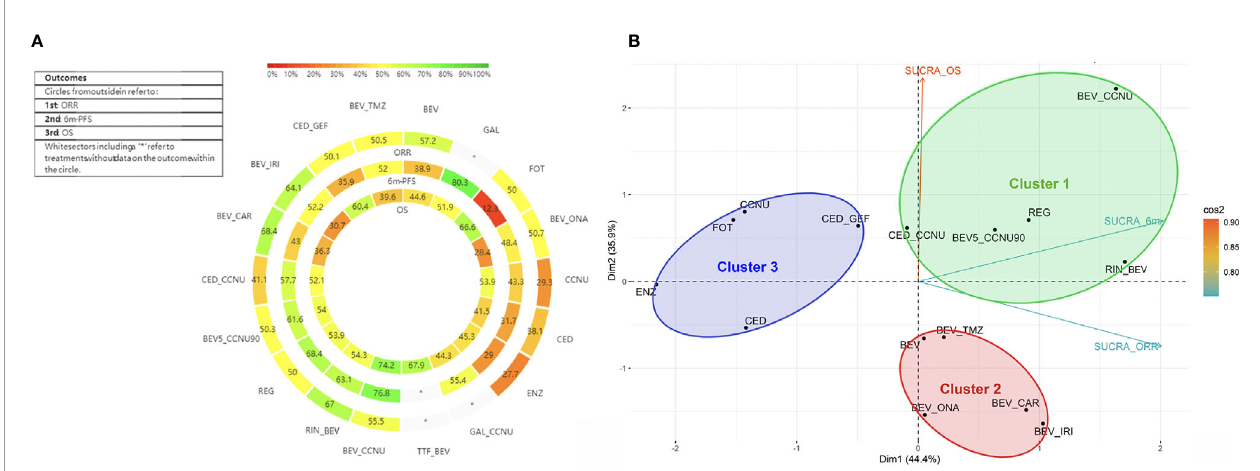
FIGURE 4 | Heat-rank plot and cluster analysis of SUCRA. (A) Heat-rank plot of SUCRA. Each circle shows the SUCRA value for ORR, 6-m PFS, and OS from outside to inside. Interactions were labeled, and each sector was colored depending on the SUCRA value. The SUCRA value scale is shown, and “ * ” refers to missing data. (B) Cluster analysis of all 3 outcomes. All therapies involved were divided into three clusters and are shown in 3 circles with distinctive colors. Clusters are shown in a two-dimensional graph by PCA, and the attribution of the SUCRA value of three outcomes to the two dimensions is shown by vectors in different colors. SUCRA_ORR, SUCRA value for ORR; SUCRA_6m, SUCRA value for 6m PFS rate; SUCRA_OS, SUCRA value for